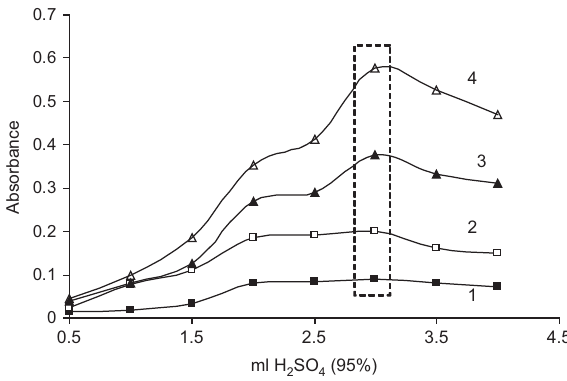
Figure 1 Effect of sulfuric acid concentration (ml) used in reaction on the absorption signal: (1) 1.55 mg NO - l -1 , and (4) 9.80 mg NO 6.25 mg NO 3